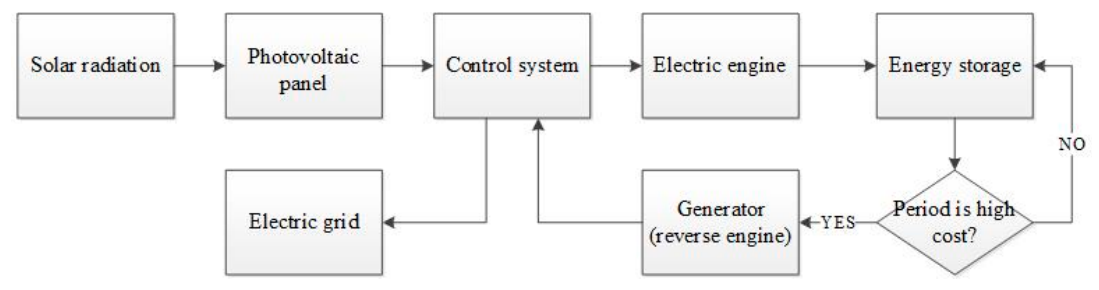
Figure 3. Simplified flowchart of the energy storage system.